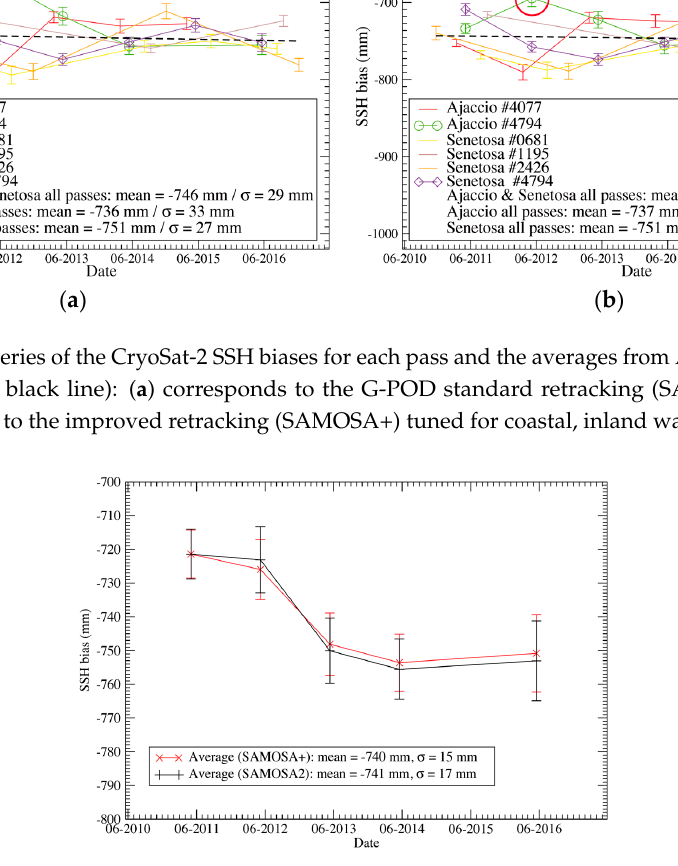
Figure 10. Example of pass #4794 with a configuration « à la » Sentinel-3A from which the SSH biases from Ajaccio and Senetosa were averaged (using SAMOSA+).